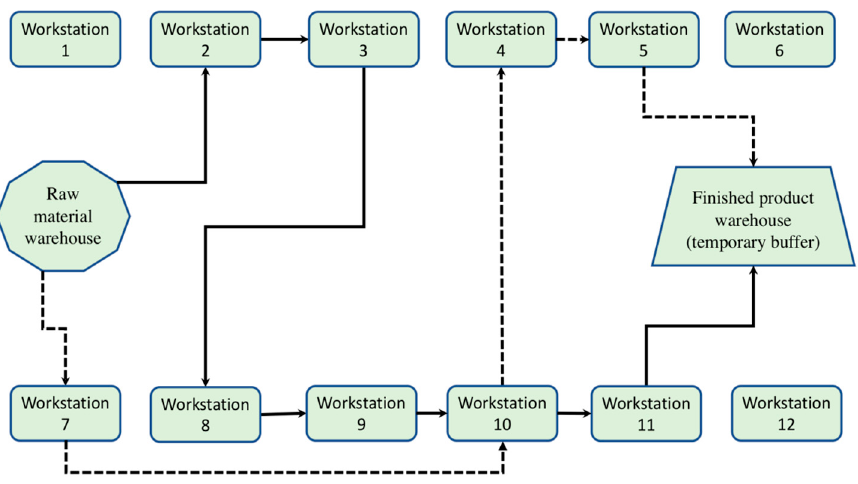
Figure 1. Two typical trajectories in a process manufacturing system. Source: Authors’ own elabo- ration.